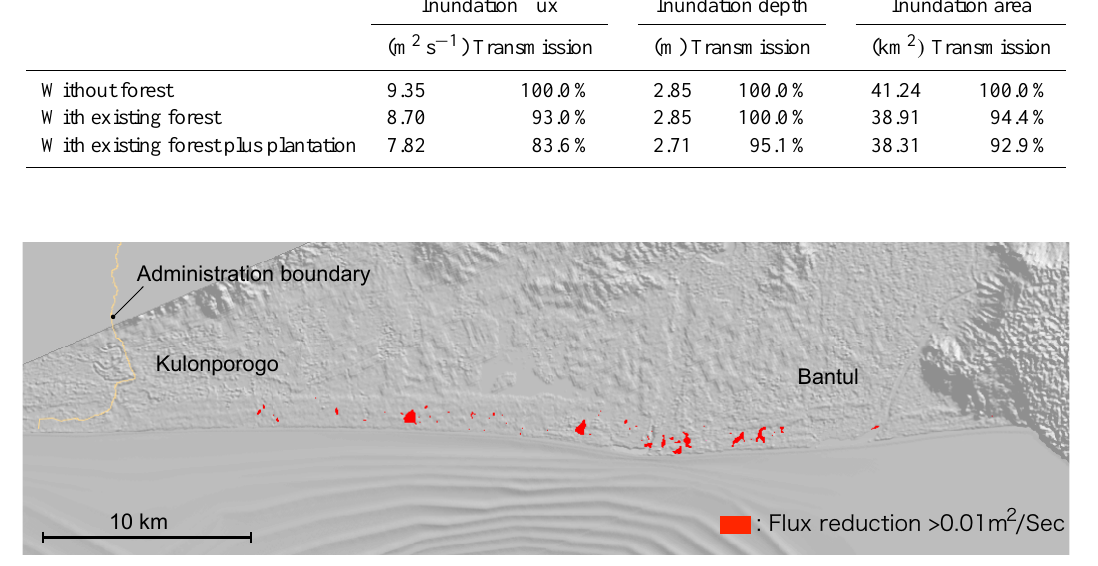
Fig. 12. The area of influence on inundation flux with the trees in 2006. While the inundation flux reduction locally appeared at the area behind the post edge of forests in 2006, reduction of flux with the planned plantation extensively appeared at the area behind the post edge of forest for both the plantations and the forests (Figs. 12 and